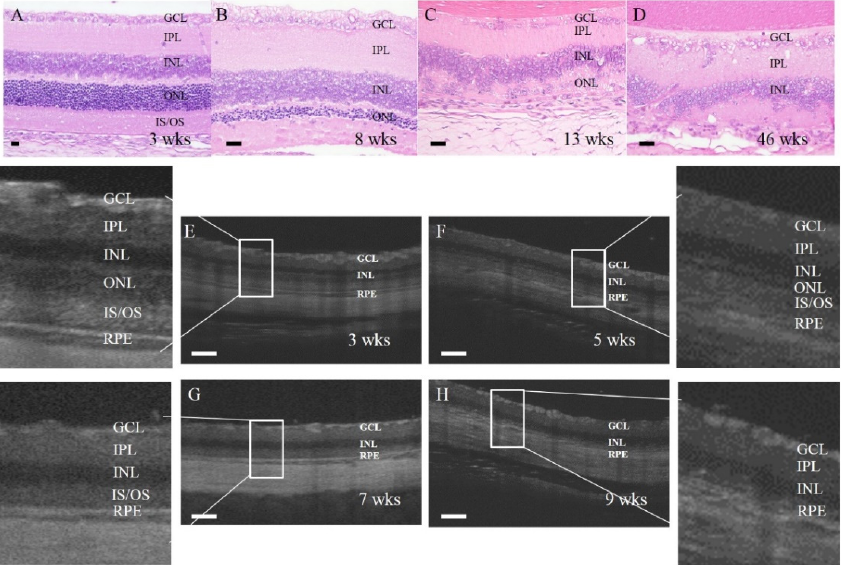
Figure 1. Retinal degeneration in RCS rats. ( A – D ) the histological structure of the rat retina at 3, 8, 13, and 46 weeks (wks) of age. ( E – H ) the representative photos of optical coherence tomography (OCT) at the fundus of RCS rats at 3, 5, 7, and 9 weeks of age. GCL: ganglion cell layer; IPL: inner plexiform layer; INL: inner nuclear layer; ONL: outer nuclear layer; IS/OS: inner segments/outer segments; RPE: retinal pigment epithelium. Scale bar in panel ( A – D ), 20 μ m; scale bar in panel ( E – H ), 100 μ m.